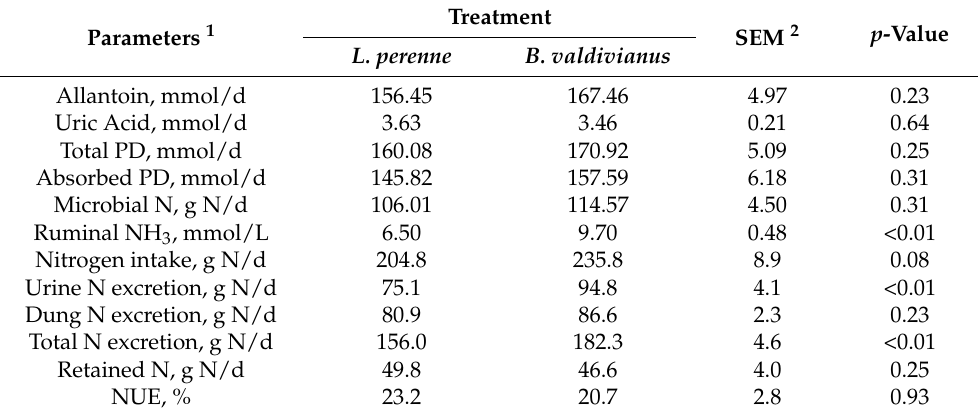
Table 3. Effect of Lolium perenne and Bromus valdivianus on purine derivates (allantoin, uric acid, total and absorbed), microbial nitrogen and ruminal ammonia of grazing dairy